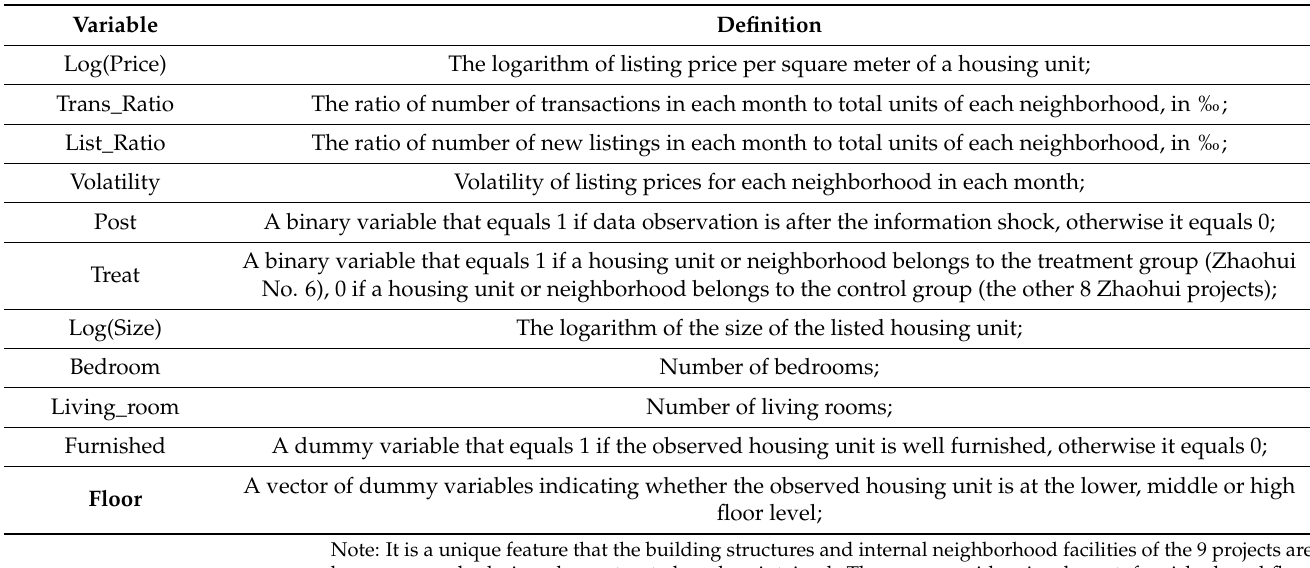
Table 1. Variable definitions.